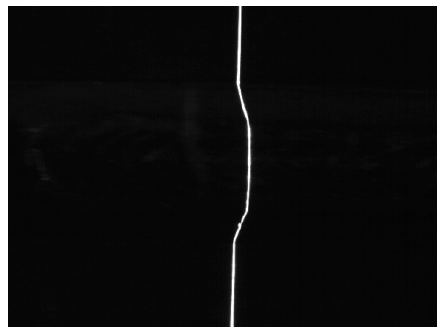
Figure 20. Laser curve image of a filler layer weld joint.